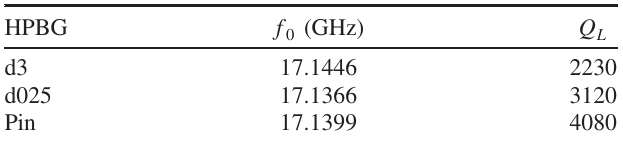
TABLE IV. Comparison of the f 0 and Q of the HPBG structures in